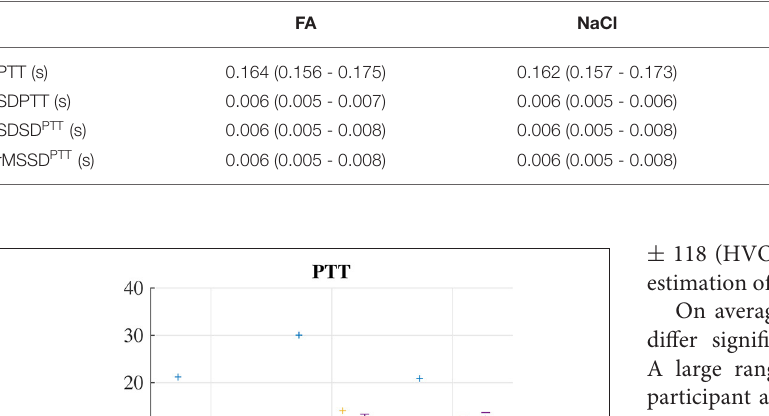
TABLE 5 | Median and interquartile range (Q 1 -Q 3 ) of pre-exposure PTT features for each exposure scenario.